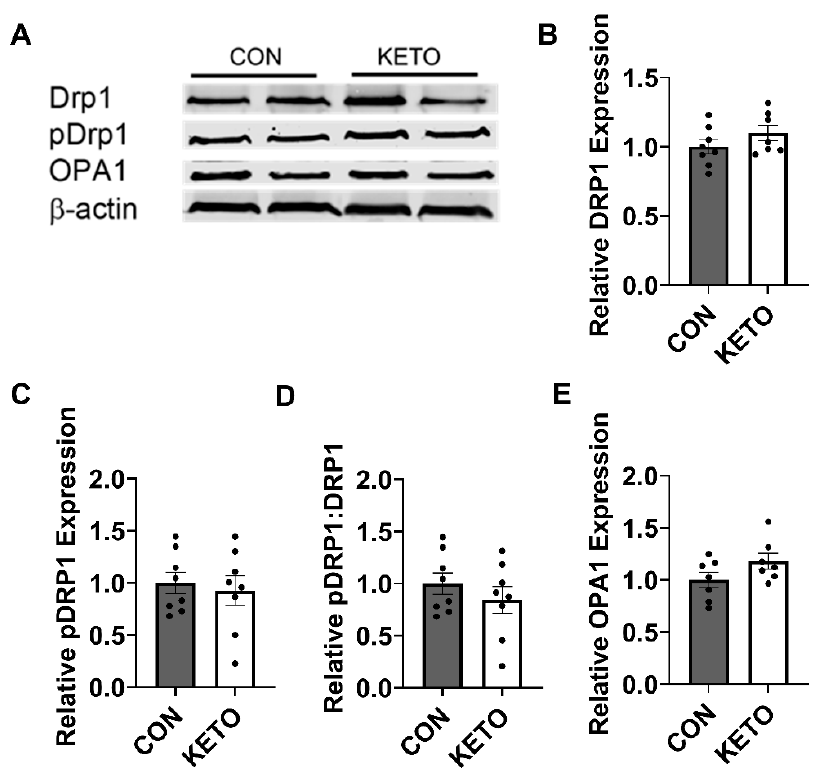
Figure 5. Ketogenic diet does not alter the hippocampal mitochondrial dynamics. ( A ) Representative Western blots against DRP1 (CON, n = 8; KETO, n = 7), pDRP1 (CON, n = 8; KETO, n = 8), OPA1 (CON, n = 7; KETO, n = 7), and their ( B – E ) respective relative quantifications.